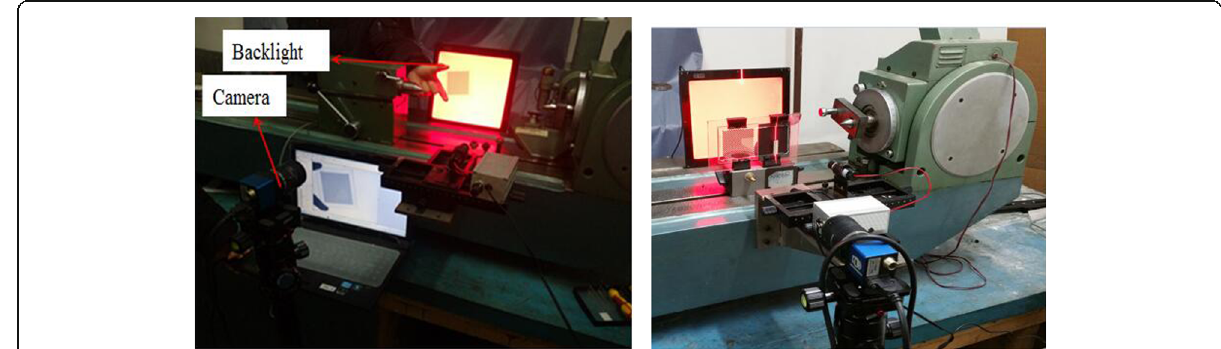
Fig. 13 Experimental equipment for measuring block gauge. a Camera calibration. b Measuring block